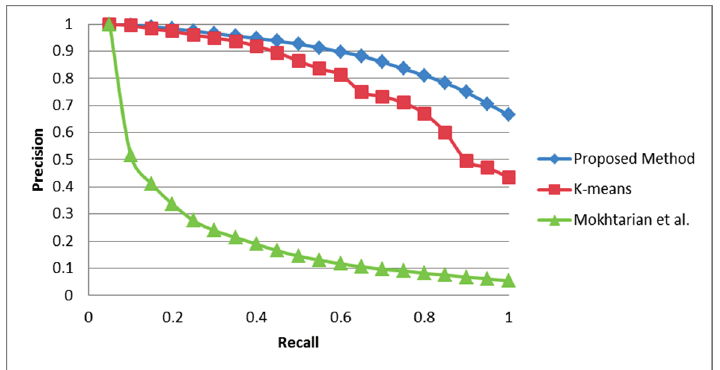
Figure 6. Average precision-recall curves of the proposed method, k -means and the automatic selection of optimal views proposed by Mokhtarian et al .